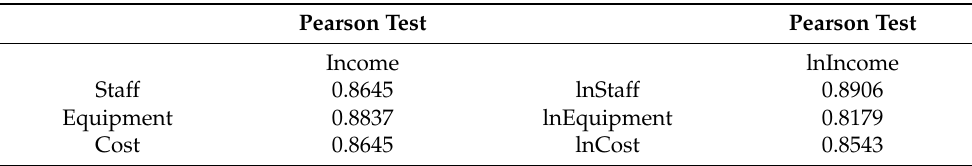
Table 2. Correlation test results of Staff, Equipment, Cost, and Income.